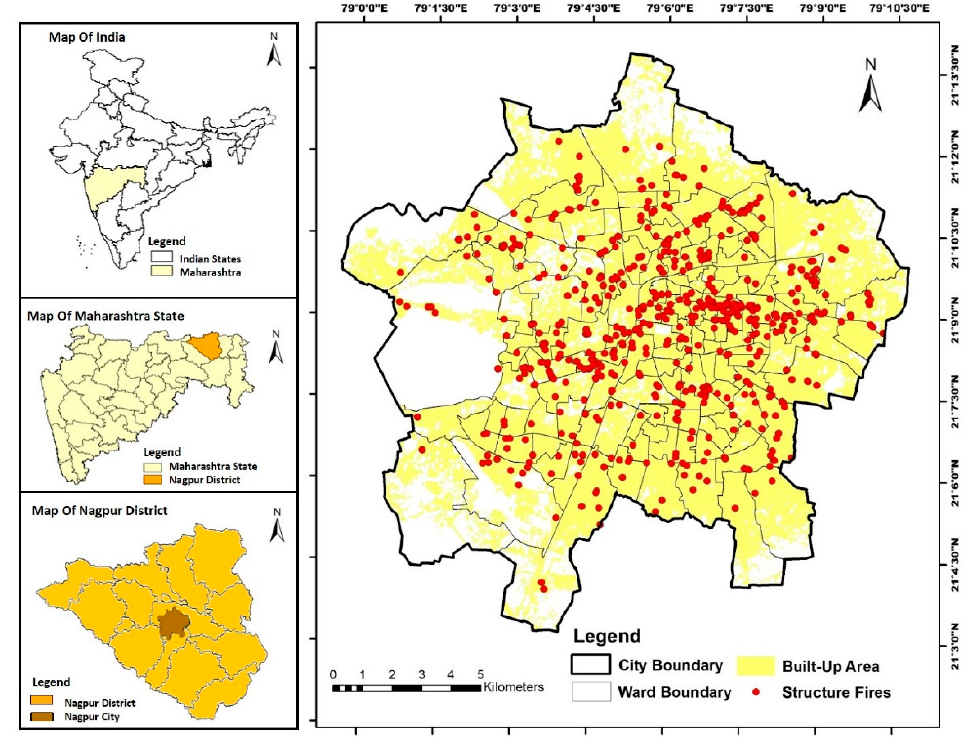
Figure 1. The geographical location of the study area with structure fires across the study